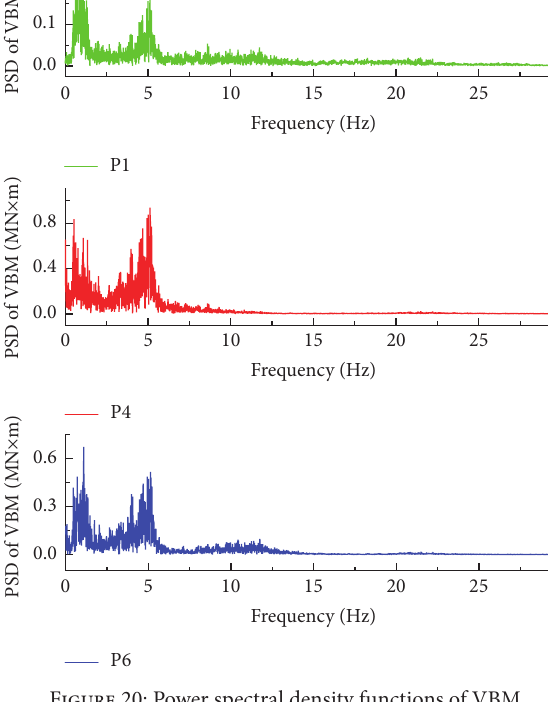
Figure 20: Power spectral density functions of VBM.